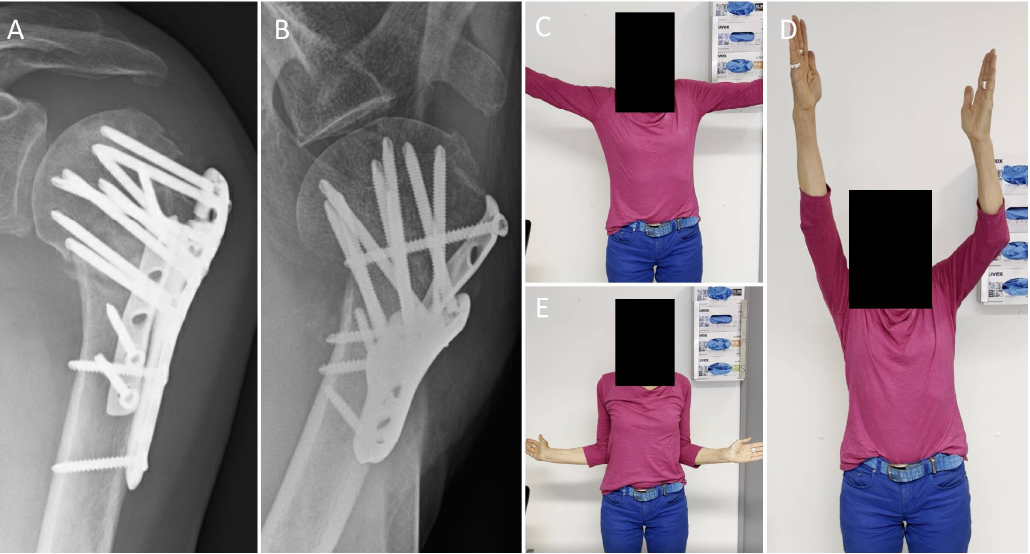
Figure 3. Radiological follow up after 5 months ap- ( A ) and axial ( B ) views. ( C – E ): Functional outcome after 5-months (same patient as Figures 1 and 2).